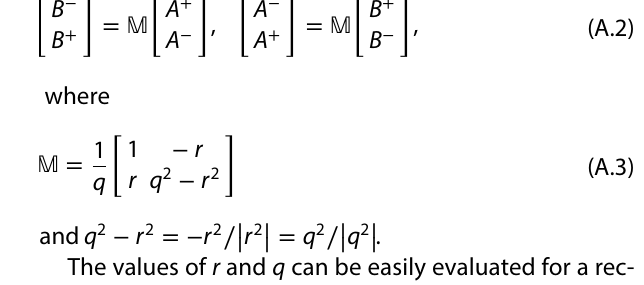
Fig. 4 Quantum tunnelling through a potential barrier: schematic of the incoming and outgoing